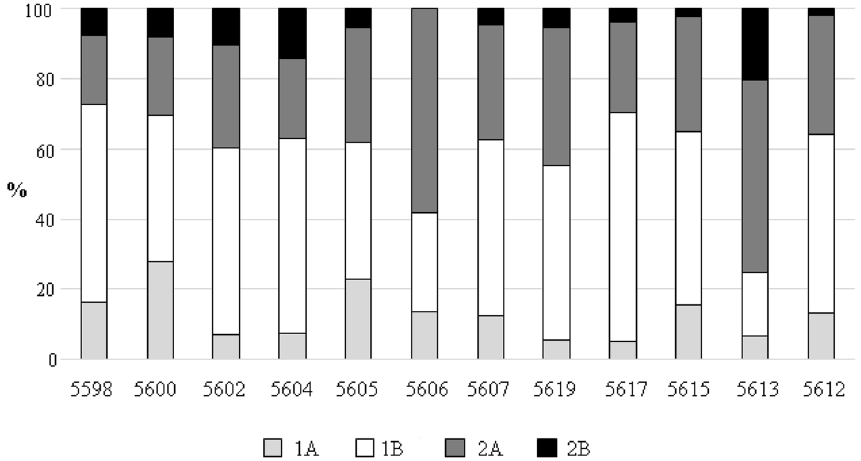
Figure 7. Percentage of nematode trophic groups revealed in the study area.. 1A—selective deposit feeders, 1B—nonselective deposit feeders; 2A—epistrate feeders; 2B—predators.